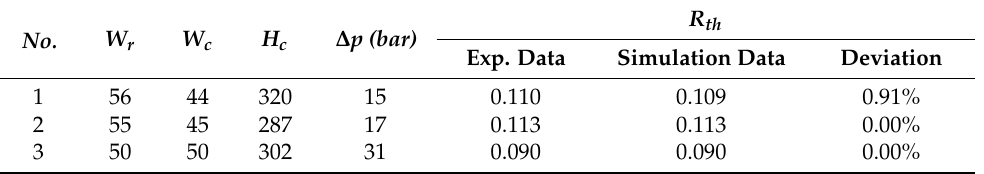
Table 5. Validation results of present study with experimental data